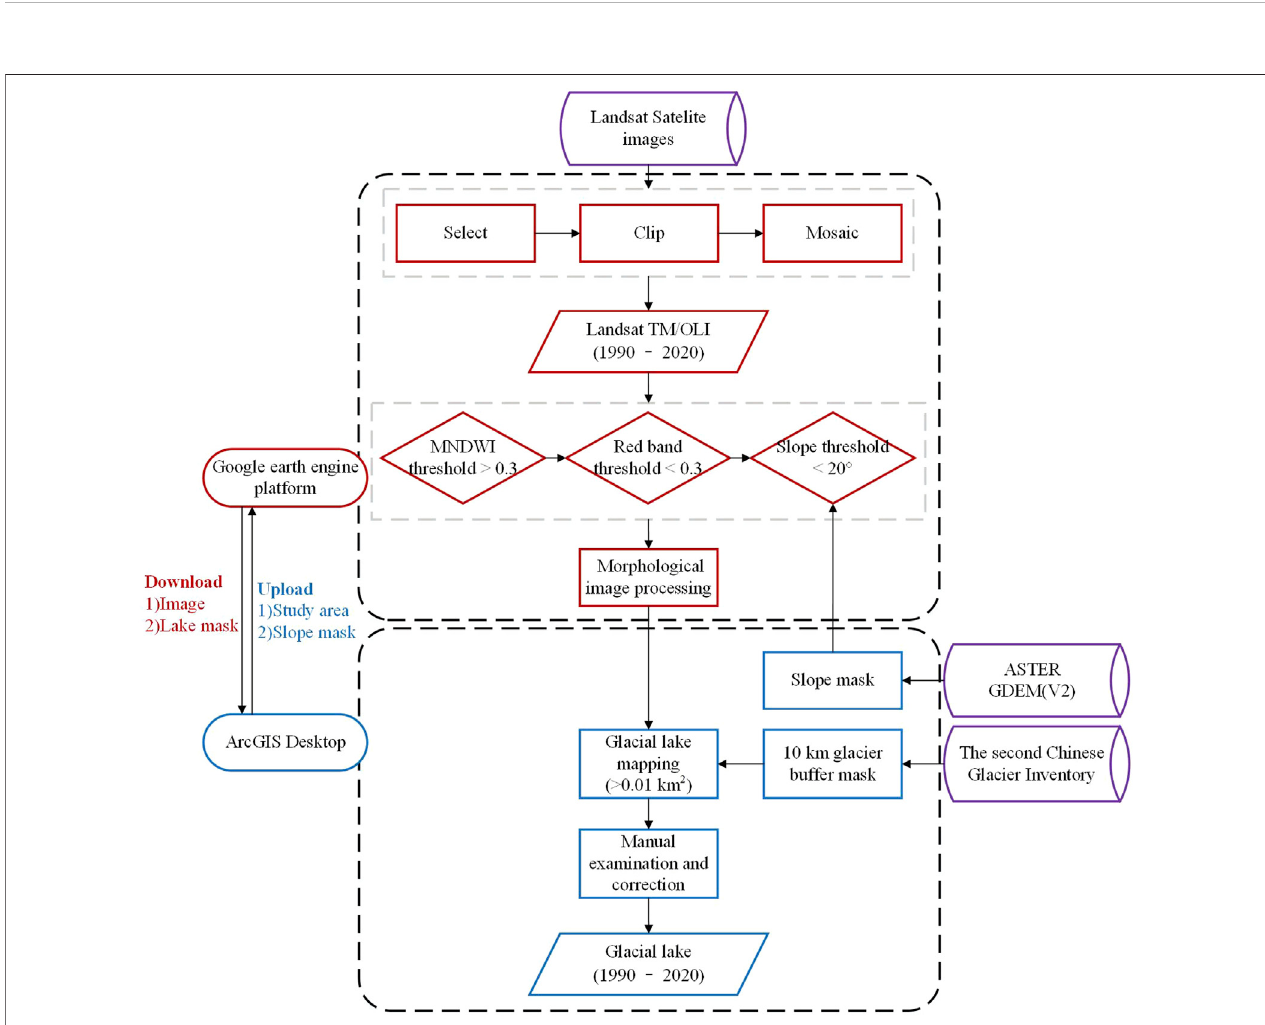
FIGURE 3 | Flow chart showing data processing used to map glacial lakes from 1990 to 2020.